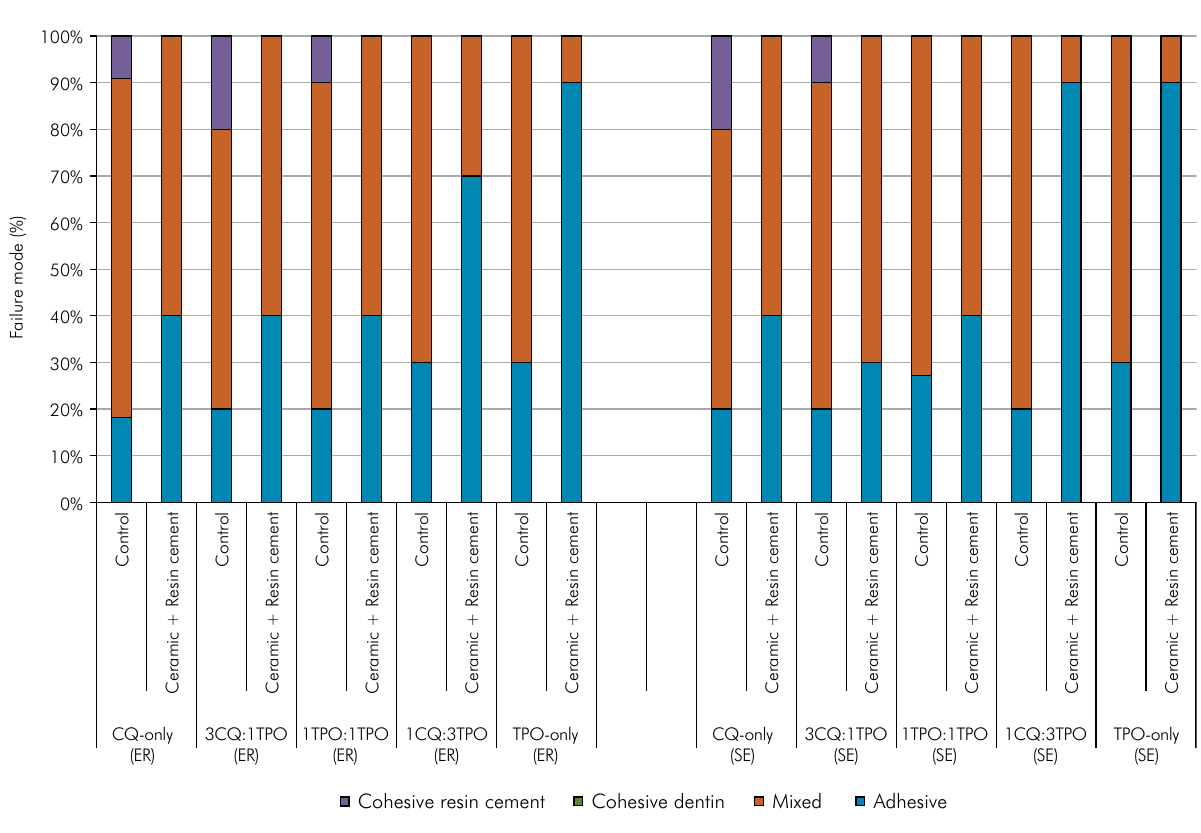
Figure 5. Failure mode analysis of debonded specimens